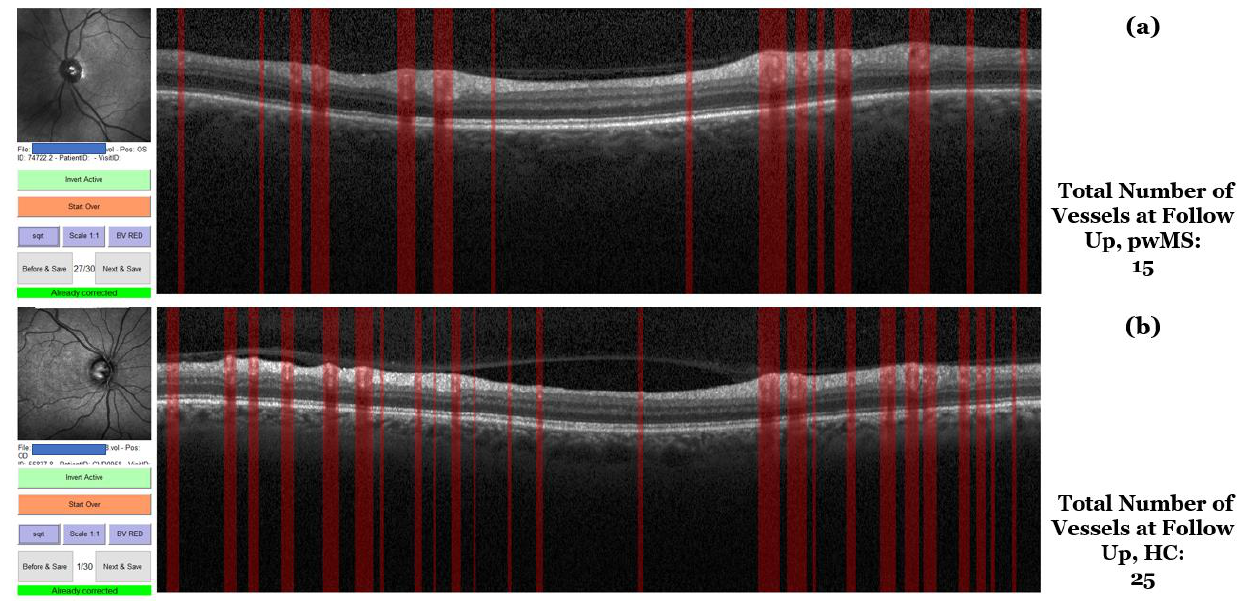
Figure 3. Comparison of an OCT of a pwMS and a HC at 5 year follow up. Legend : pwMS—person with multiple sclerosis, HC—healthy control, OCT—optical coherence tomography. ( a ) A figure showing the segmentation of the pwMS’s OCT. ( b ) A figure showing the segmentation of the HC’s OCT at 5 year follow up. Table 4. Longitudinal changes in retinal vasculature over the